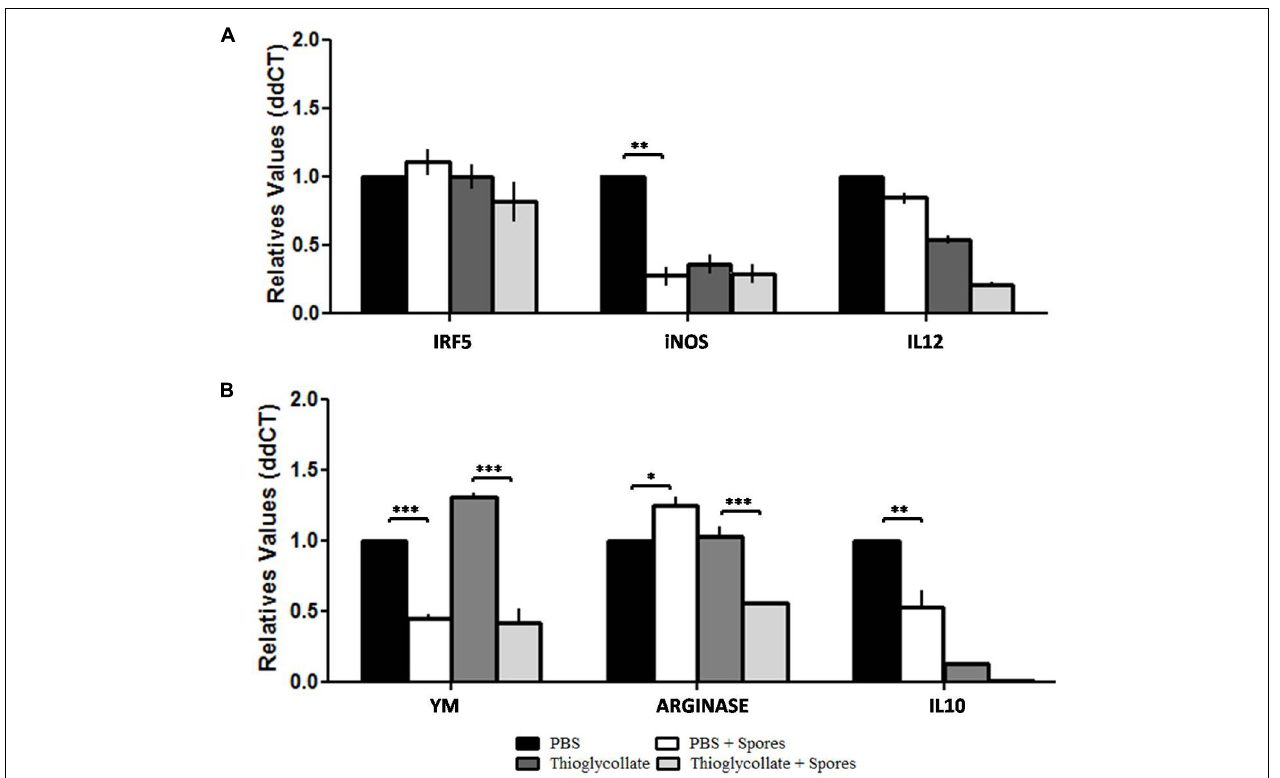
FIGURE 4 | Transcriptional levels of (A) IRF5, iNOS and IL12, (B) YM, ARGINASE and IL10. M1/M2 gene expression profile of C57BL/6 peritoneal macrophages after different mice treatments (PBS, PBS + spore, thioglycollate and thioglycollate + spore) obtained by quantitative PCR. Data represented as mean ±